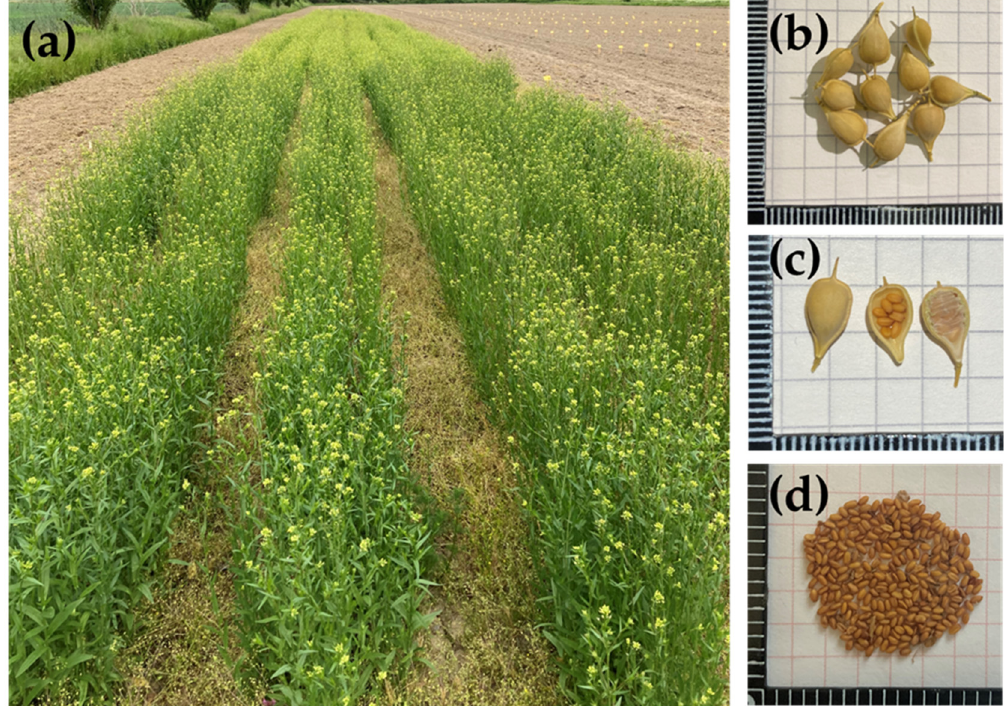
Figure 1. Camelina sativa crop. ( a ) Flowering plants; ( b ) silique; ( c ) opened silique; ( d ) seeds. The weight of 1,000 seeds is in the range of 0.8 to 2.0 grams. The seeds contain 38 to 43% oil, and 27% to 32% protein. Camelina reproduces through seed and is primarily a self-pollinating species [4,5].